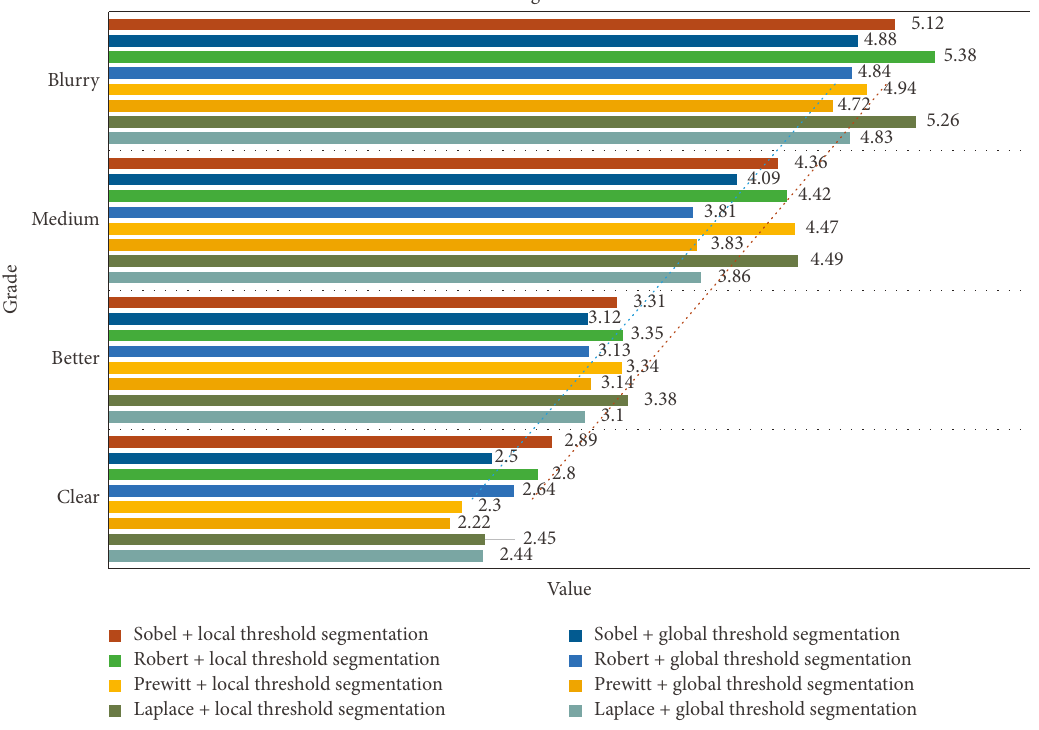
Figure 2: Different threshold segmentation methods combined with an edge detection processing